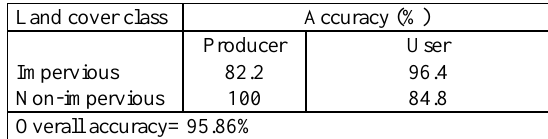
Table 6. Producer and user accuracy (ALOS/PALSAR full polarimetric + GLCM